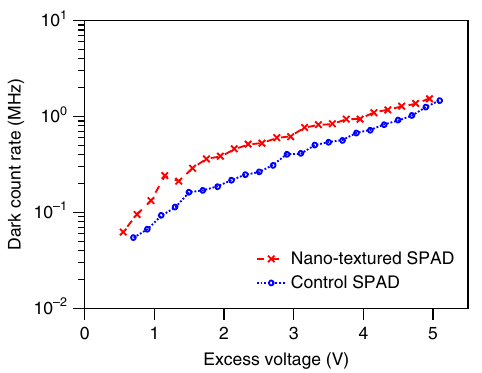
Fig. 5 Dark count rate. Dark count rate comparison of thicker-junction SPADs (3.5 μ m) on Si substrates with and without